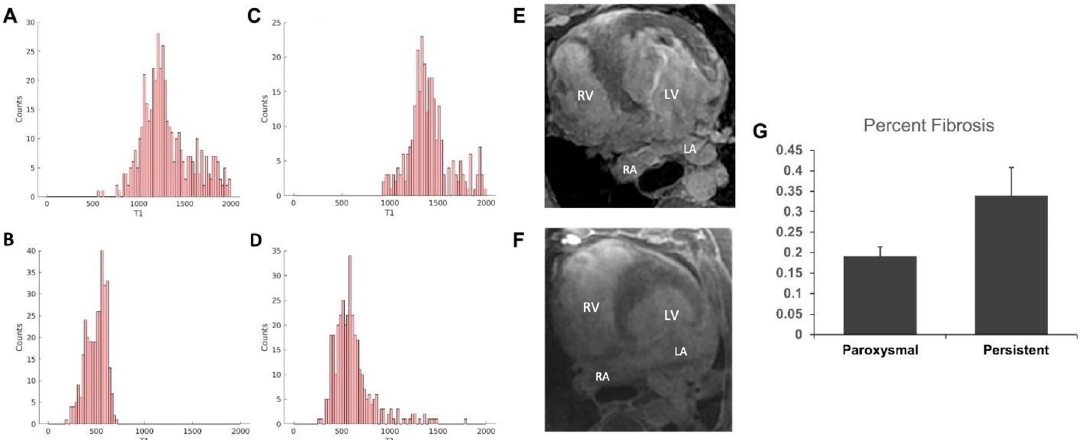
Fig 8. Cardiac fibrosis quantification by magnetic resonance imaging in pigs. Example T1 relaxation times of paroxysmal AF (A) pre- gadolinium and (B) post- gadolinium MRI imaging. Similar analysis of T1 relaxation time in Persistent AF of (A) pre-gadolinium and (B) post-gadolinium showed an average increase of 181.67ms (pre- Gd), and average decrease of 175ms (post-Gd). (E) Persistent AF MRI demonstrating left atrial fibrosis compared to (F) Paroxysmal AF MRI demonstrating absence of left atrial fibrosis. (G) ECV calculation demonstrated an increased level of tissue fibrosis in persistent AF compared to paroxysmal AF (p = 0.05).